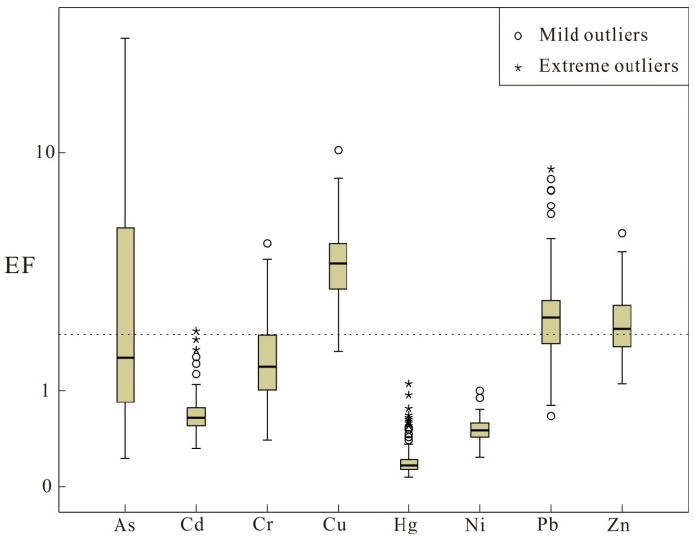
Figure 4. Boxplot for enrichment factors of heavy metals in stream sediments of the Misiones province.